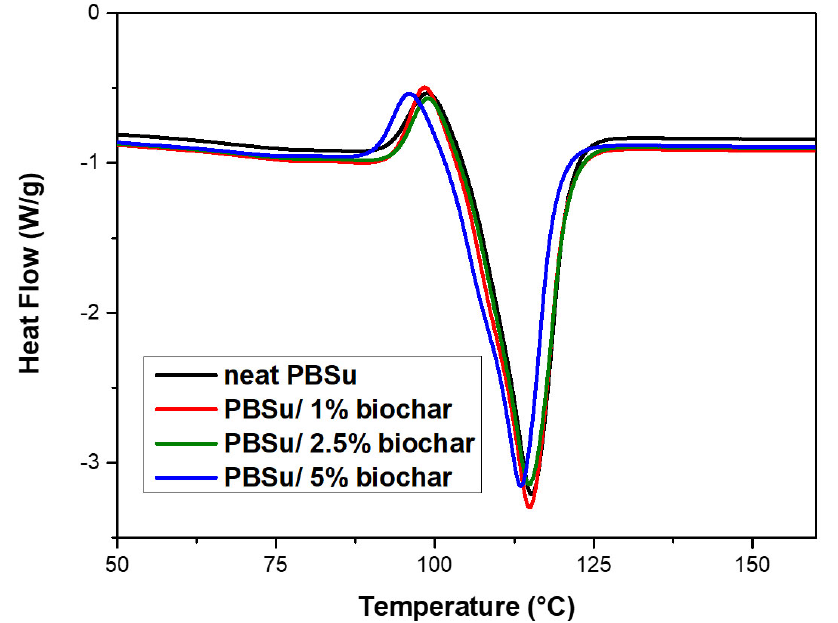
Figure 3. Melting peak temperatures of neat PBSu and PBSu/biochar composites at the heating rate of 20 °C/min.